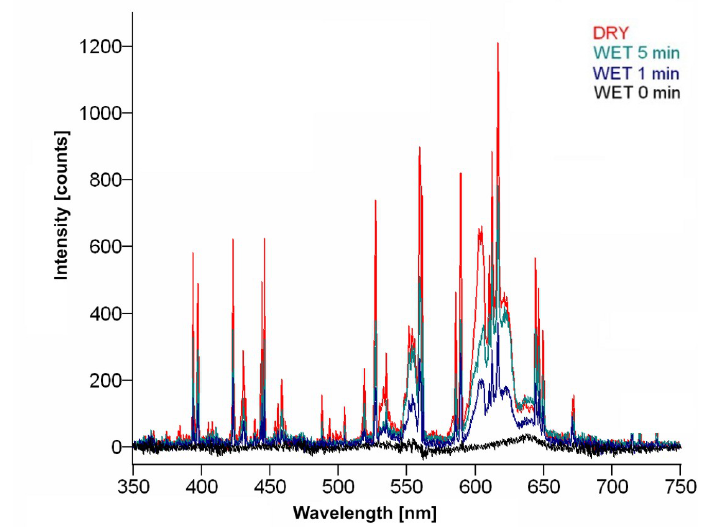
Figure 10. Comparison of emission spectra for sandstone encrustation during dry and wet laser cleaning.